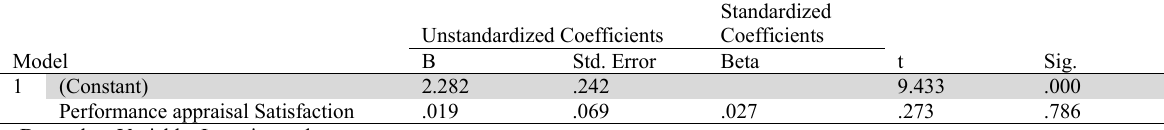
The summary of the regression analysis